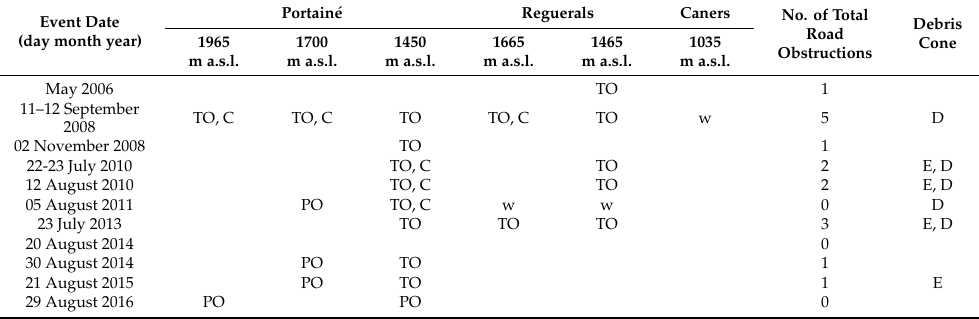
Table 2. Historical record for the occurrence of recent torrential flows in the Portainé catchment and their effects on road intersections, indicated by their altitude (TO: total obstruction of the culvert; PO: partial obstruction of the culvert; C: talus collapse; w: water circulation) and by the downstream debris cone (E: erosion; D: deposition).